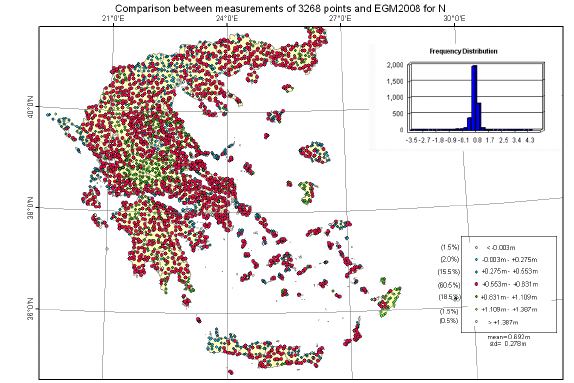
Figure 9: Geographical distribution of the geoid heights’ residuals based on EGM2008 computed values and GPS/levelling data. Data refer to 3268 data points over the Hellenic region.